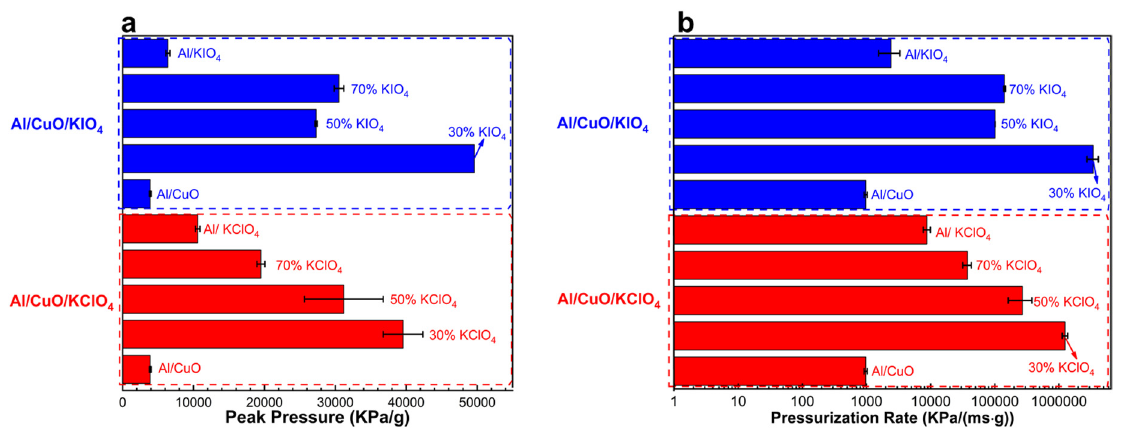
Figure 3. The measured peak pressure ( a ) and pressurization rate ( b ) of Al/CuO/potassium oxysalts systems. Note: “70%” means “Al/CuO/70% potassium oxysalts”.